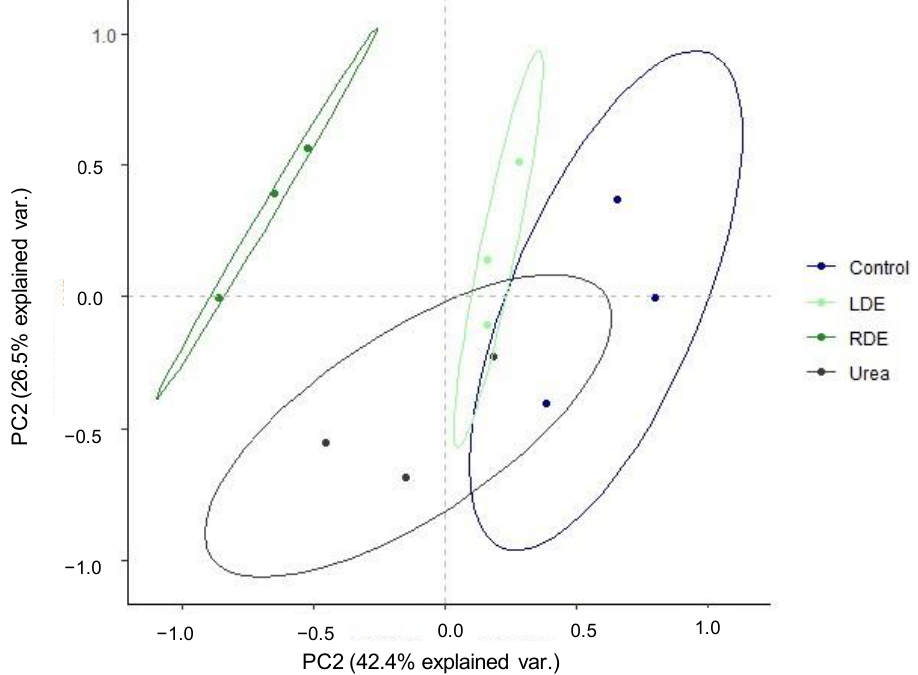
Figure 3. Principal component analysis of Biolog EcoPlates incubated for 96 h containing pot soil of fescue pasture upon the application of raw dairy effluent (RDE), lagoon-stored effluent (LDE), urea, or no fertilization (control). Ellipses indicate 95% confidence intervals.